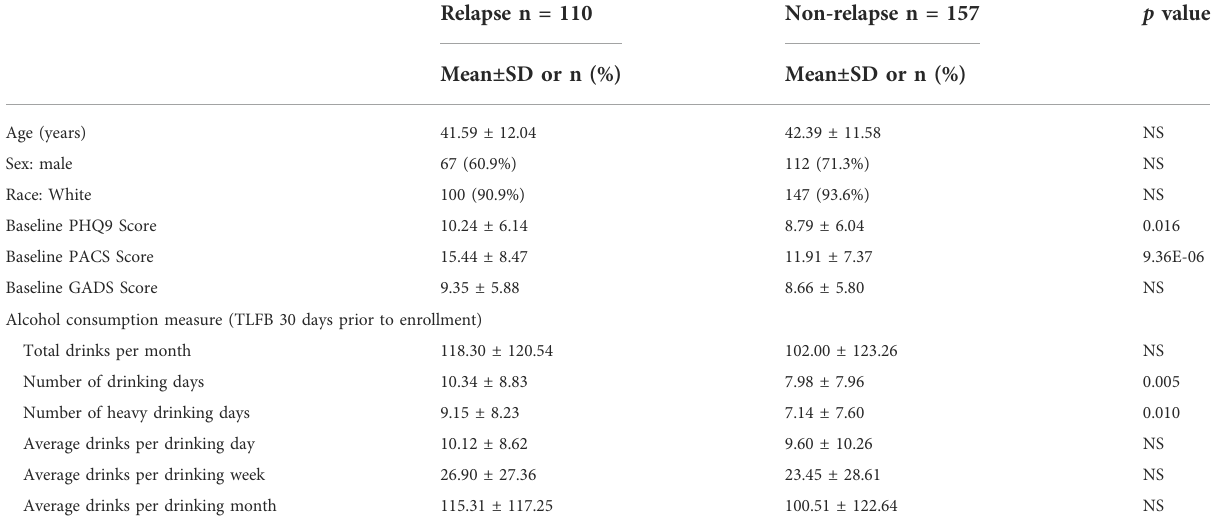
TABLE 1 Demographic and clinical characteristics of the